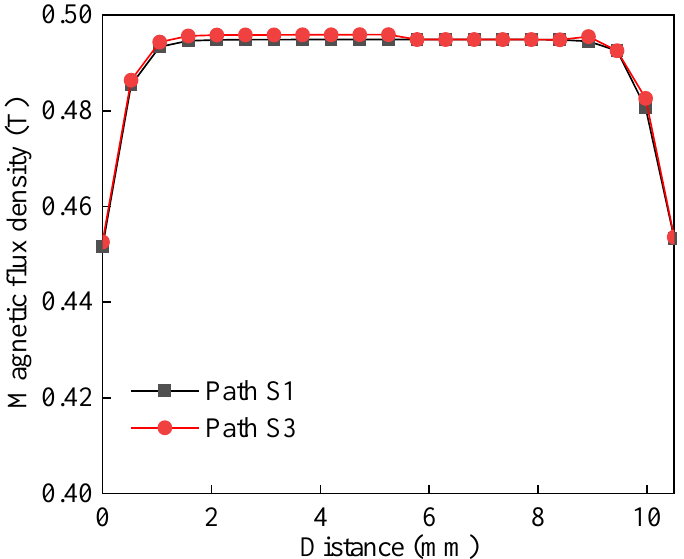
Figure 11. Distribution of magnetic flux density in disk damping gap.